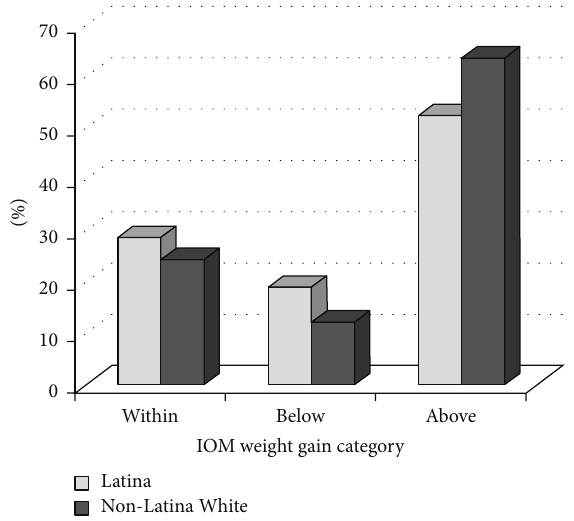
Figure 1: Gestational weight gain status among White non-Latina and Latina women.